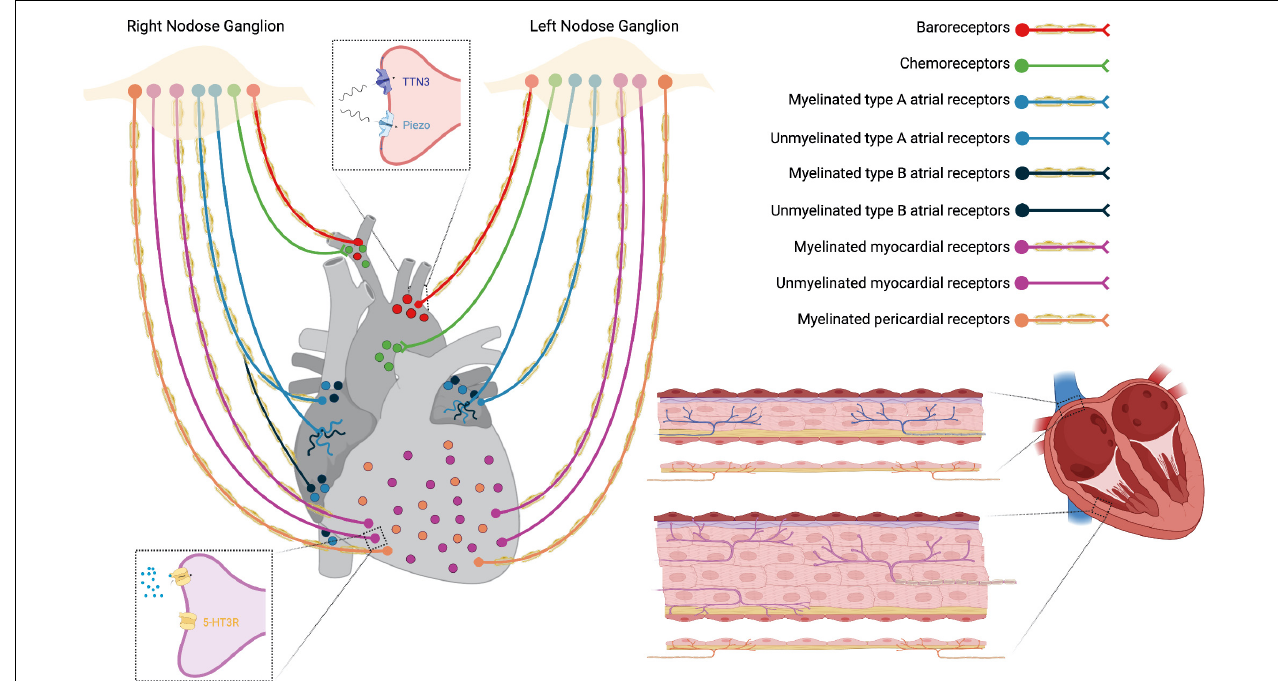
FIGURE 3 | Schematic representation of thoracic cardiovascular afferent fibers running in the vagus nerve. Insets: top, baroreceptors Piezo2 + and TTN3 + terminals; down, unmyelinated 5-HT3R + myocardial receptors.